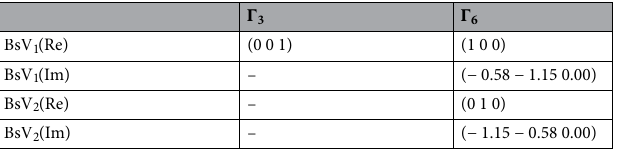
Table 2. Basis vectors of the irreducible representations of the magnetic propagation vector group G k for the Cr atom in polycrystal LiCrTe 2 . Note that Ŵ 3 is collinear and Ŵ 6 is helical (also imaginary component). Ŵ 3 clearly gives a better agreement with our NPD data (see main